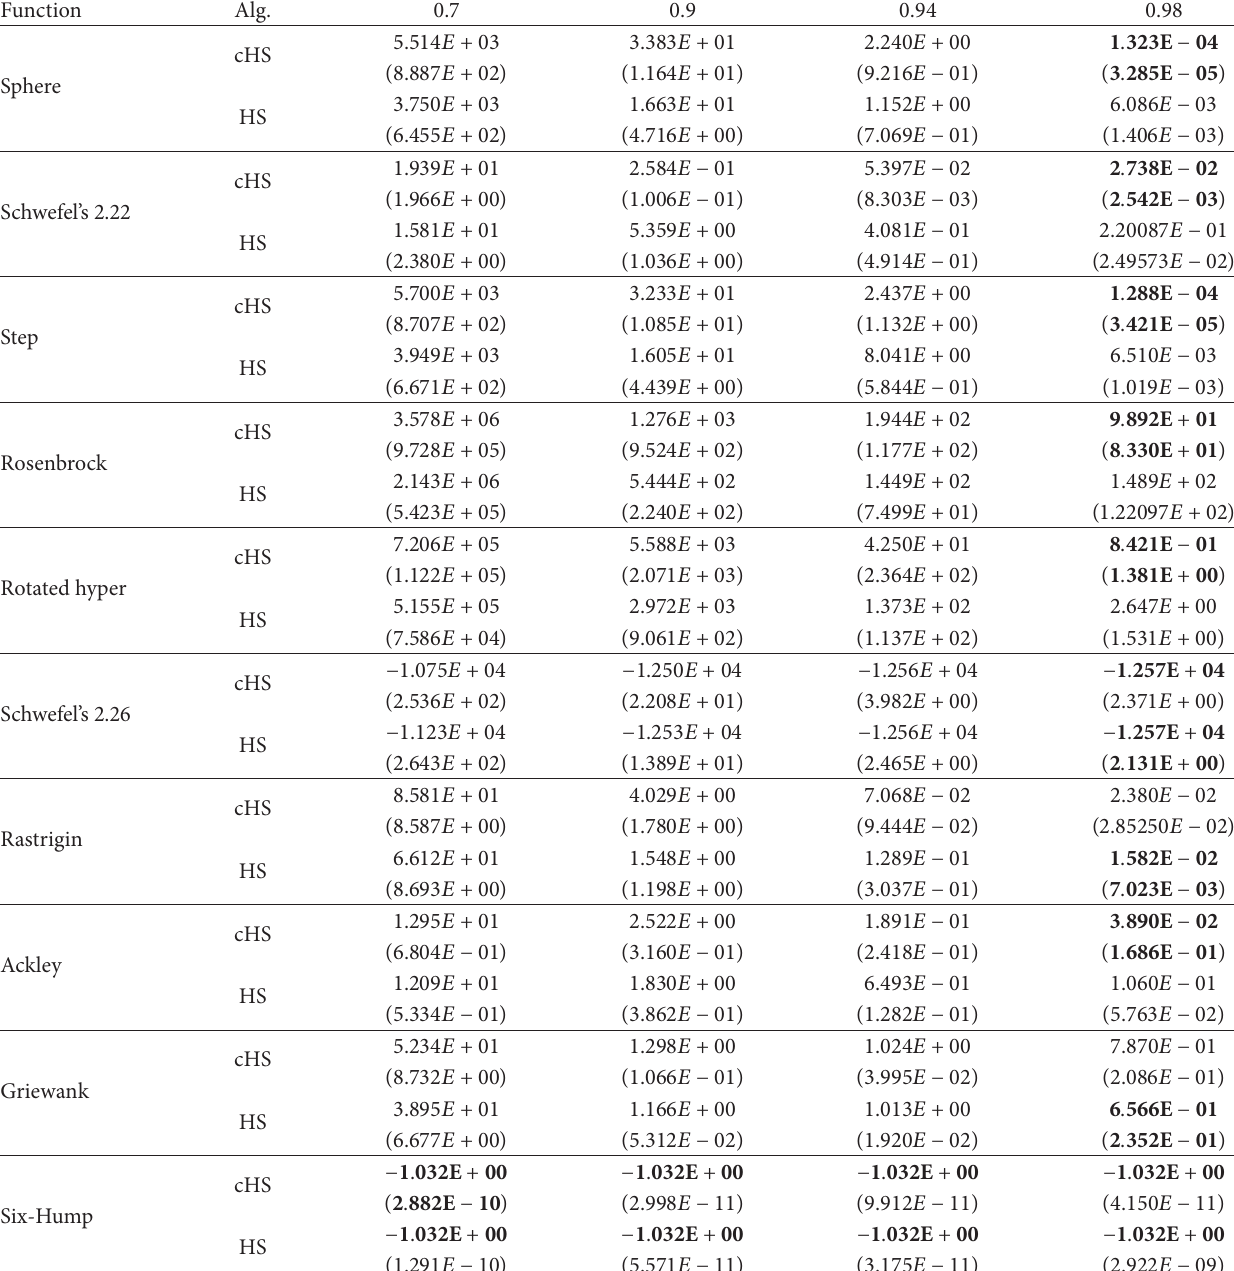
Table 4: The effect of varying the HMCR parameter on HS and cHS for ten functions ( 𝑓 1 – 𝑓 10